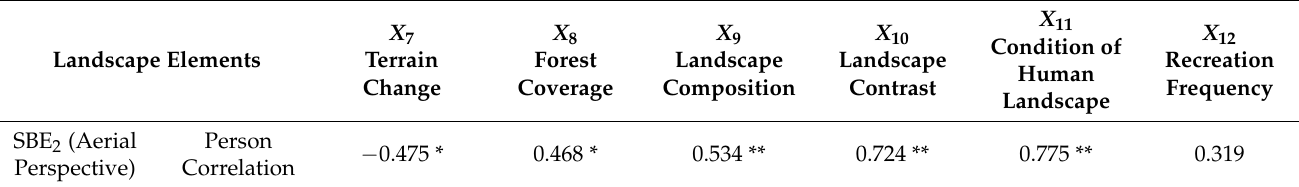
Table 6. Pearson correlation between landscape elements and SBE from the aerial